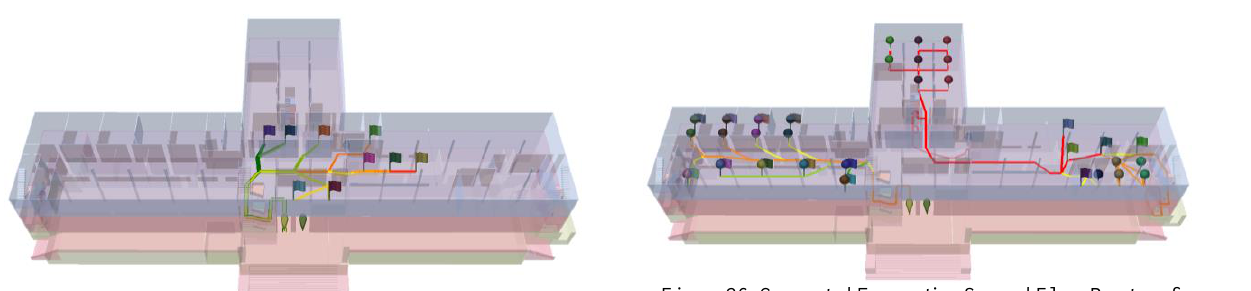
Figure 26. Generated Evacuation Second Floor Routes of